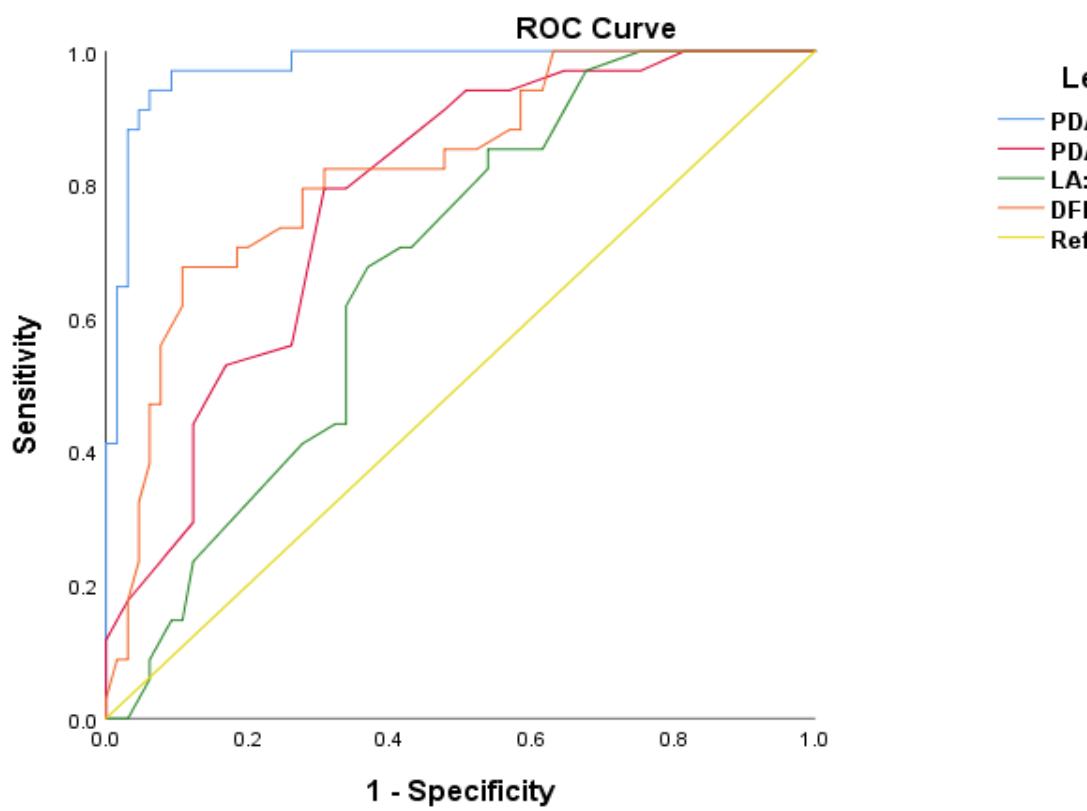
Figure 3. Relationship between PDAss and predicted probability of CLD/death of the entire cohort.